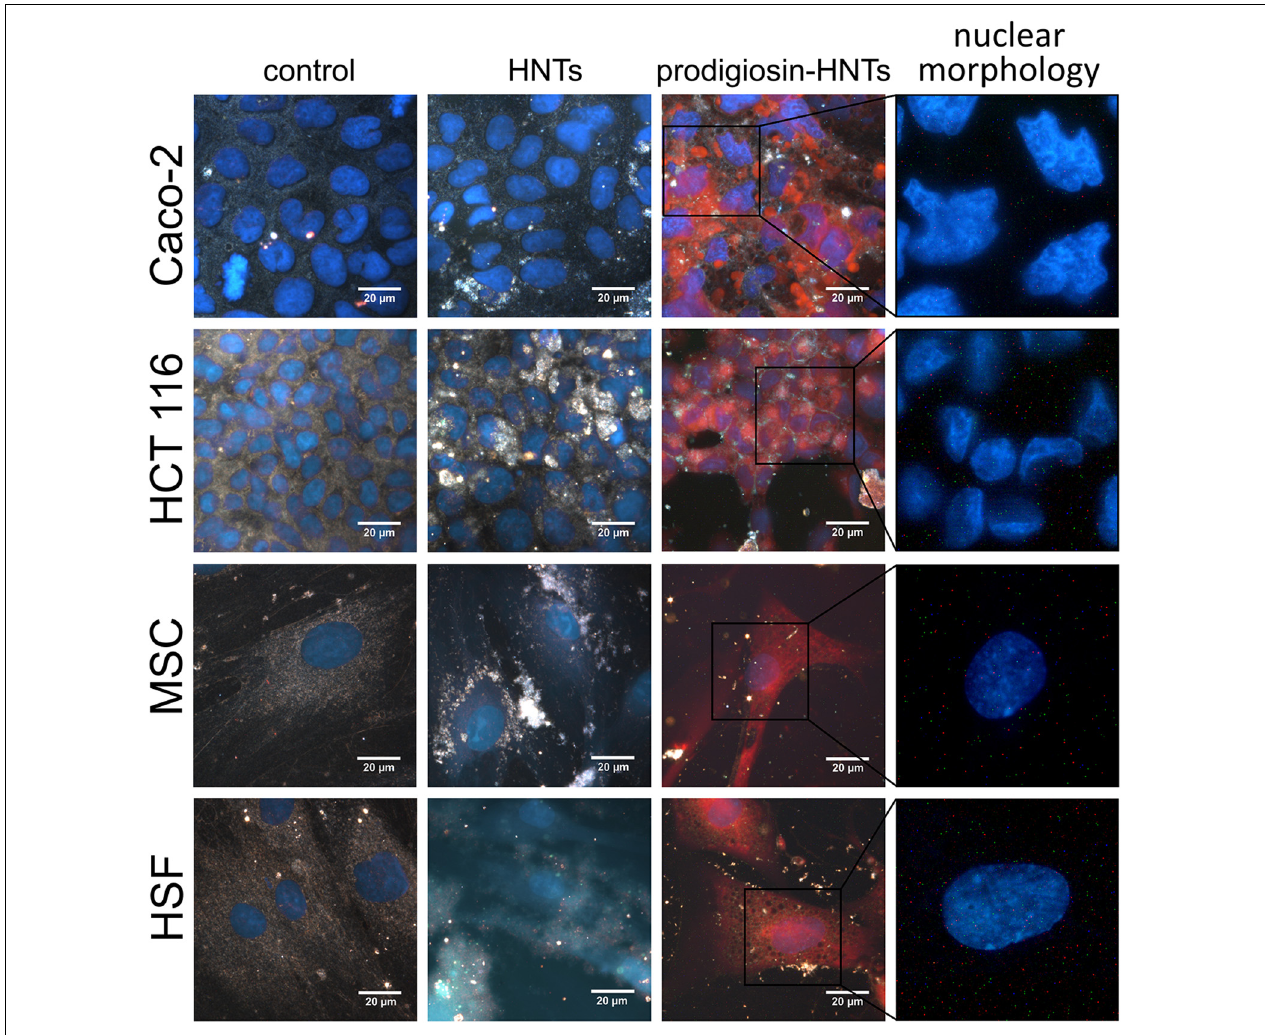
FIGURE 4 | Hyperspectral images for comparison of the effect of halloysite nanotubes loaded with glycerol (HNTs) and prodigiosin-HNTs on malignant (Caco-2, HCT 116) and non-malignant cells (MSC, HSF). All cultures were grown in α -MEM with 5% CO 2 in air and humidity at 37 ◦ C. Nuclei (blue) were labeled with DAPI. Purple non-specific staining of the cells cytoplasm (prodigiosin-HNTs column) is the result of autofluorescence of prodigiosin released from prodigiosin-HNTs into the cytoplasm. Changes in nuclear morphology of Caco-2 and HCT 116 cells treated with p-HNTs shown in the far right